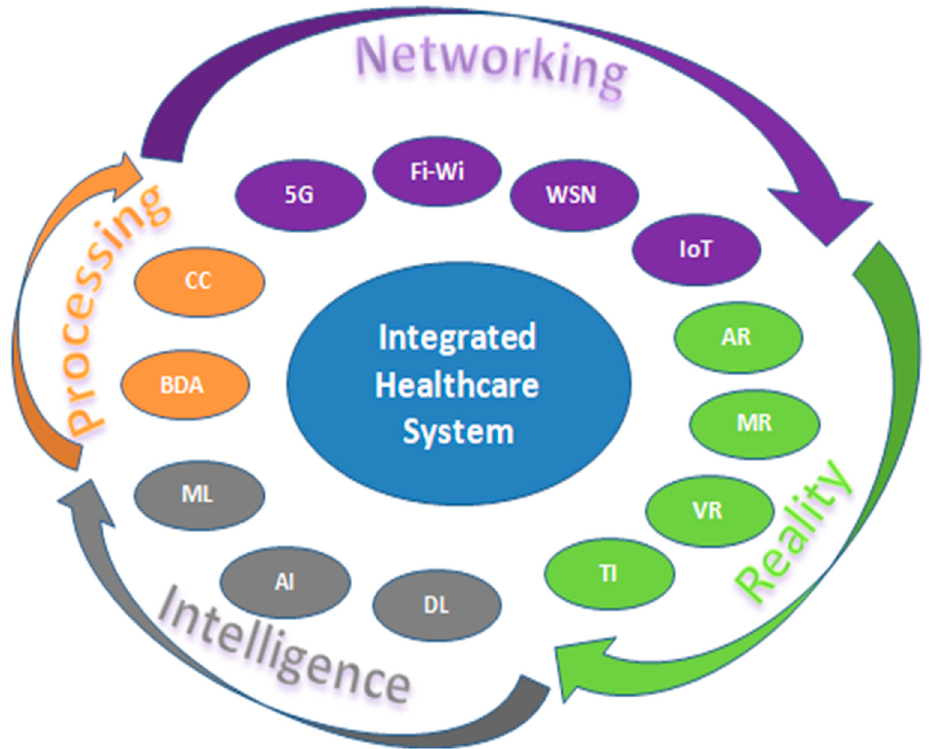
Figure 1. Combination of various emerging technologies into an integrated healthcare system.